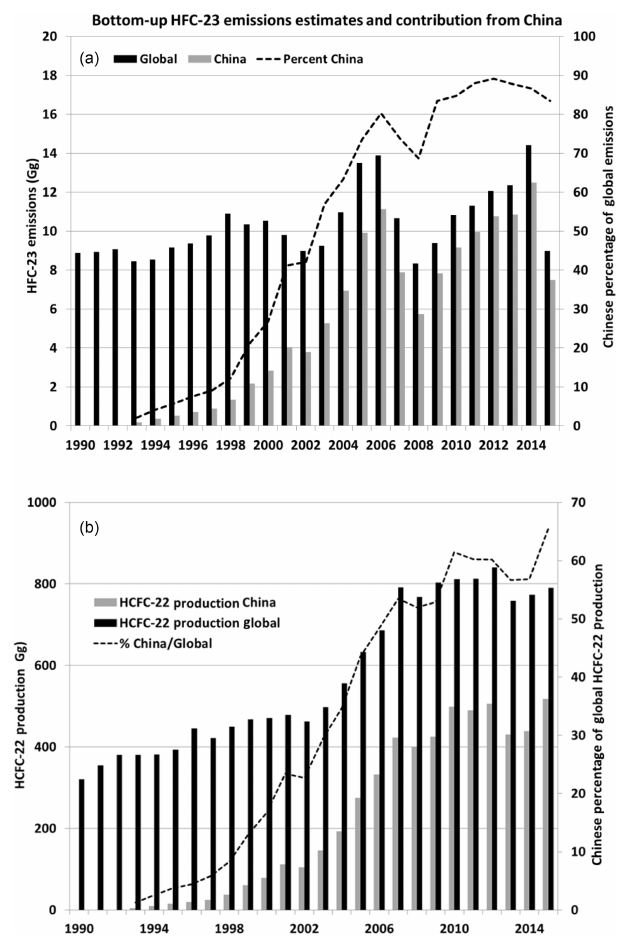
Figure 5. (a) HFC-23 global and Chinese emissions estimates and the percentage of Chinese emissions contributing to the global total (dashed line). Compiled from Table S4 in the Supplement. (b) HCFC-22 emissions estimates of global and Chinese produc- tion and the percentage of Chinese production as a fraction of the global total (dashed line). Compiled from Table